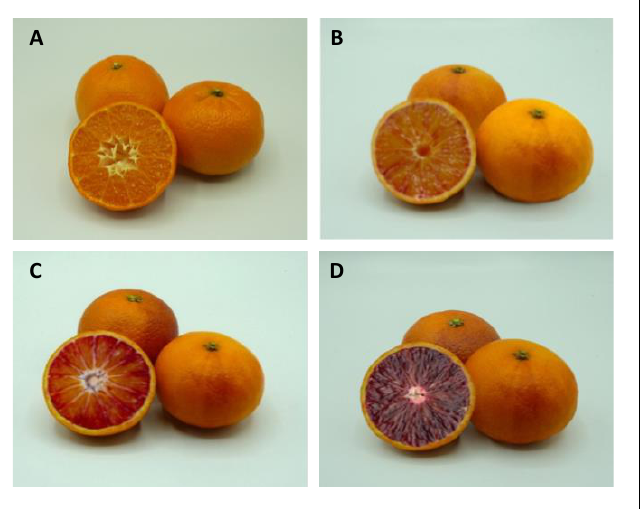
Figure 1. Pictures of normal ( A ), slight ( B ), medium ( C ) and intense pigmented ( D ) mandarins shown in the questionnaire.